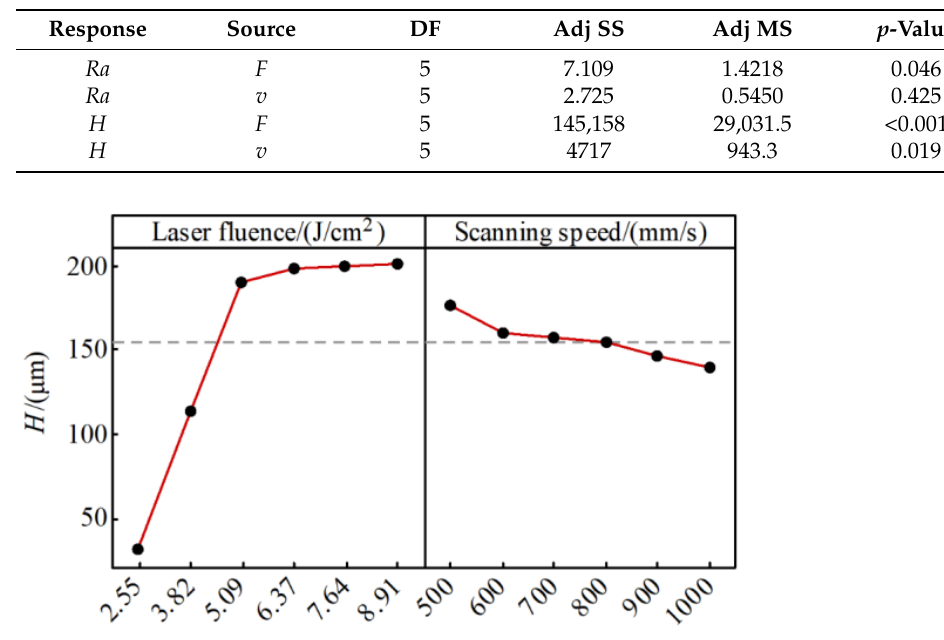
Figure 10. Main effects plot for stripping thickness.